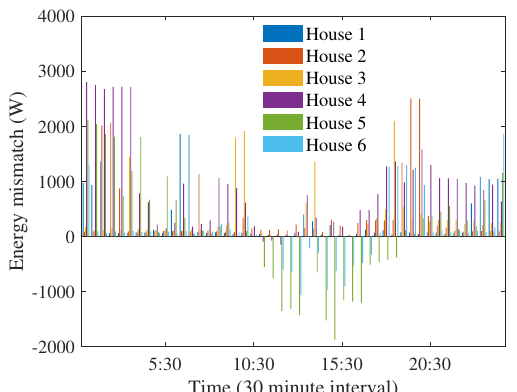
Figure 6. Energy mismatch at the 6 houses in the microgrid with energy trading when priorities are not